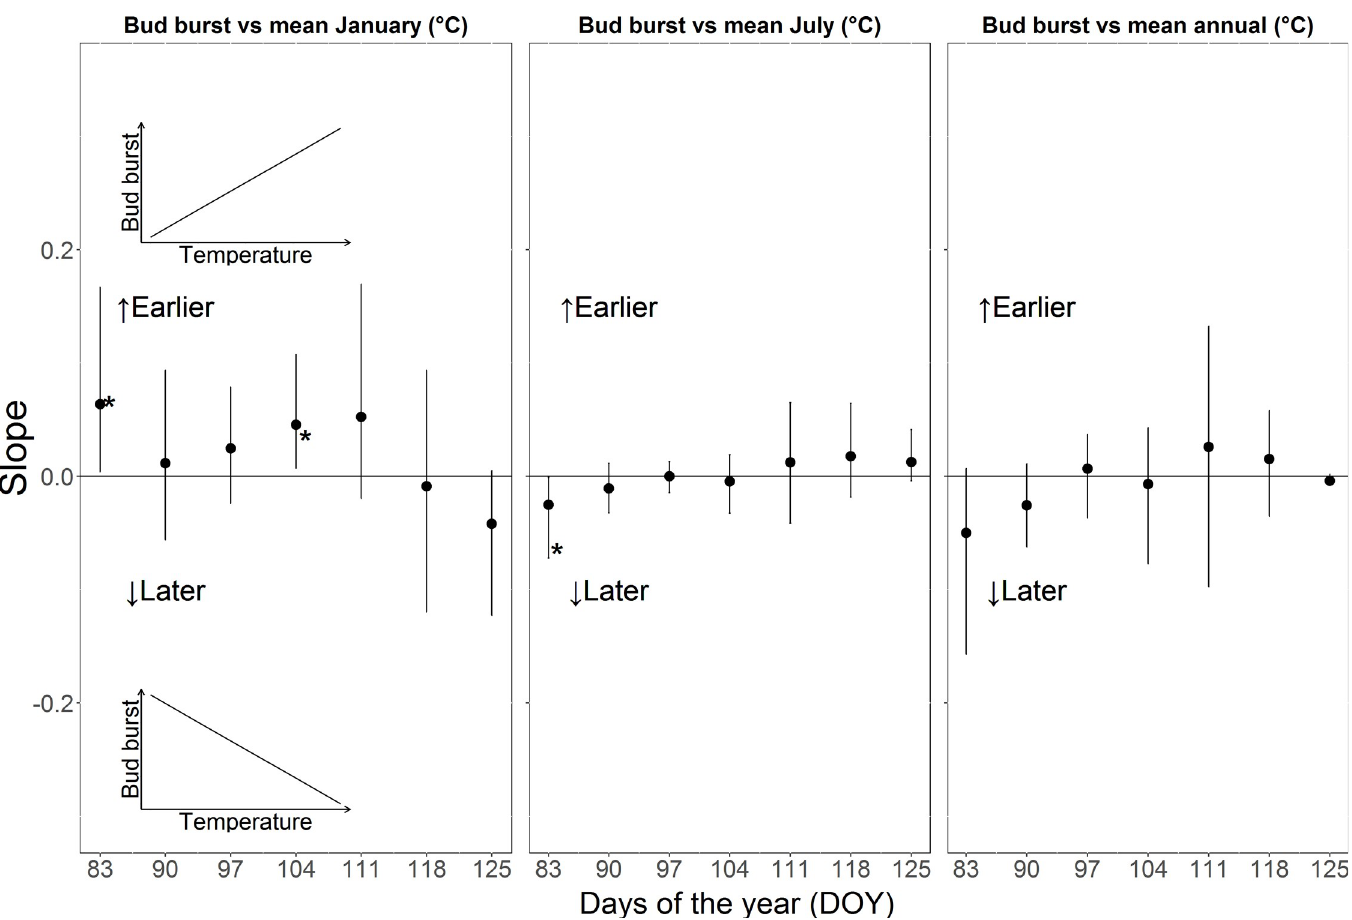
Fig 1. Mean weighted (bootstrapped) slopes of the relationship between the mean bud burst score in 2015 and mean January, July and mean annual temperatures experienced by the parent trees. Error bars denote 95% confidence intervals (upper and lower) across the 500 bootstrapped values. Significances at the 95% level are denoted by � . ‘Earlier’ means that buds burst earlier with increasing temperatures and ‘Later’ means that buds burst later with increasing temperatures.